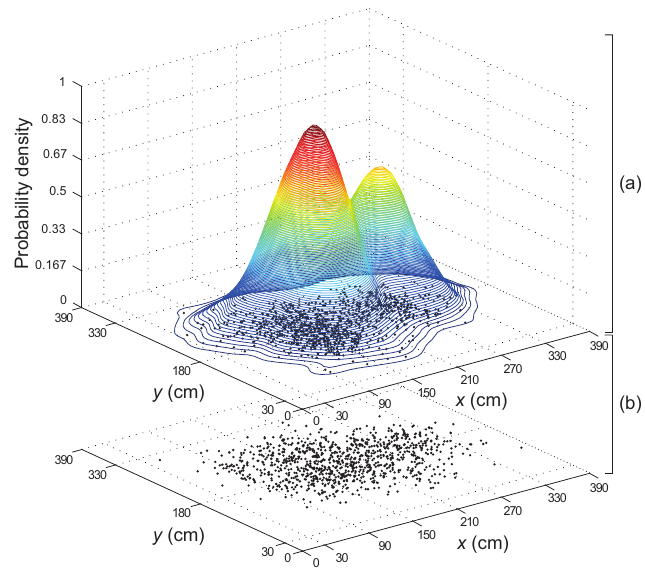
Figure 3. DSPF algorithm with ( a ) target and ( b ) proposal distributions that consist of particles with x -axis and y -axis coordinate